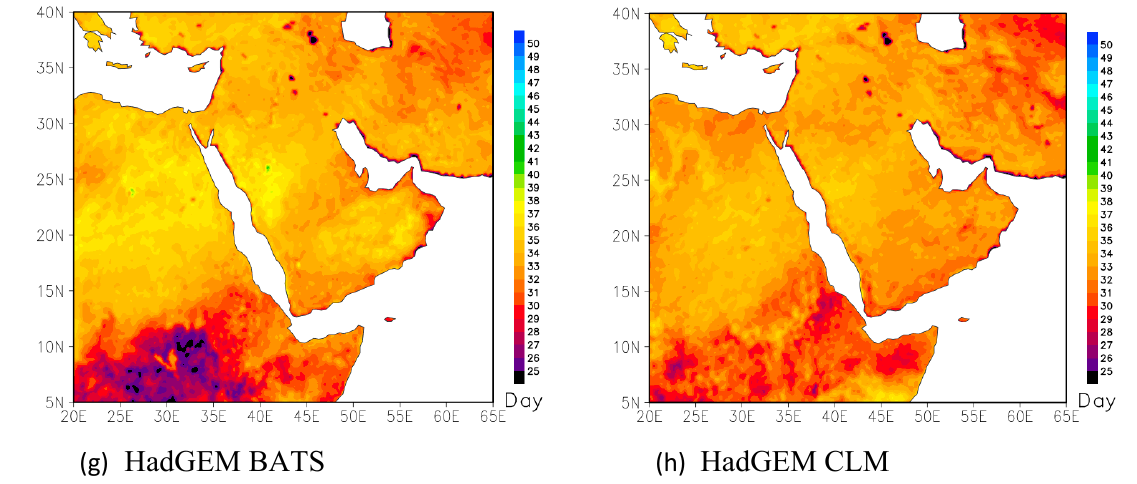
Figure 7. Spatial distribution of annual cold nights (TN10p) for ( a ) ERA – Int BATS, ( b ) ERA – Int CLM, ( c ) ECHAM6 BATS, ( d ) ECHAM6 CLM, ( e ) GFDL BATS, ( f ) GFDL CLM, ( g ) HadGEM BATS, and ( h )